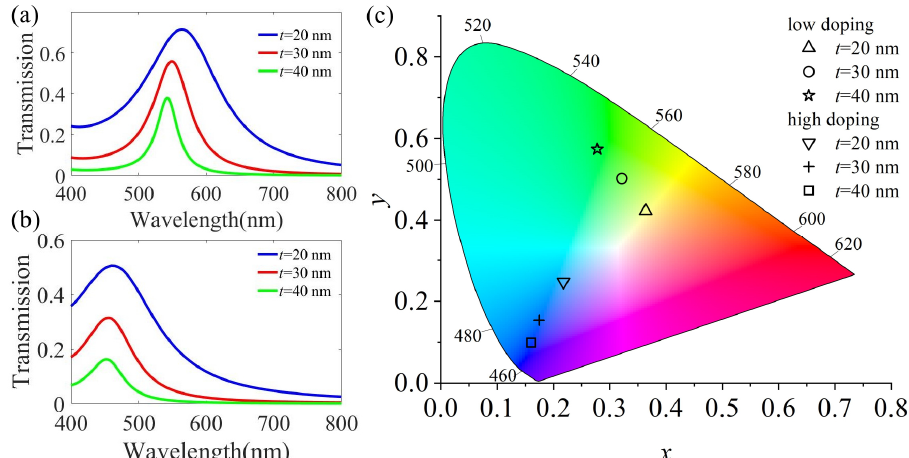
Figure 6. ( a ) Simulated spectral transmittance curves at normal incidence with different t for green, d = 90 nm. ( b ) The corresponding transmission spectrum after plasma treatment with H 2 . ( c ) An illustration of color coordinates calculated from the transmission spectra studied in ( a , b ).